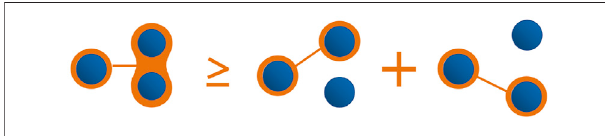
FIGURE 1 | (color online). Schematic picture of the CKW-type monogamy relation described by Eq. 1